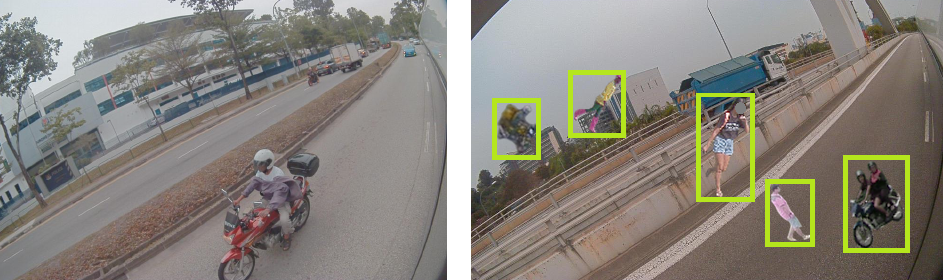
Figure 6. ( Left ) Sample image from side camera, showing the unconventional viewing angle of objects not found in public datasets. ( Right ) Generated image with objects and their bounding boxes imposed on a random